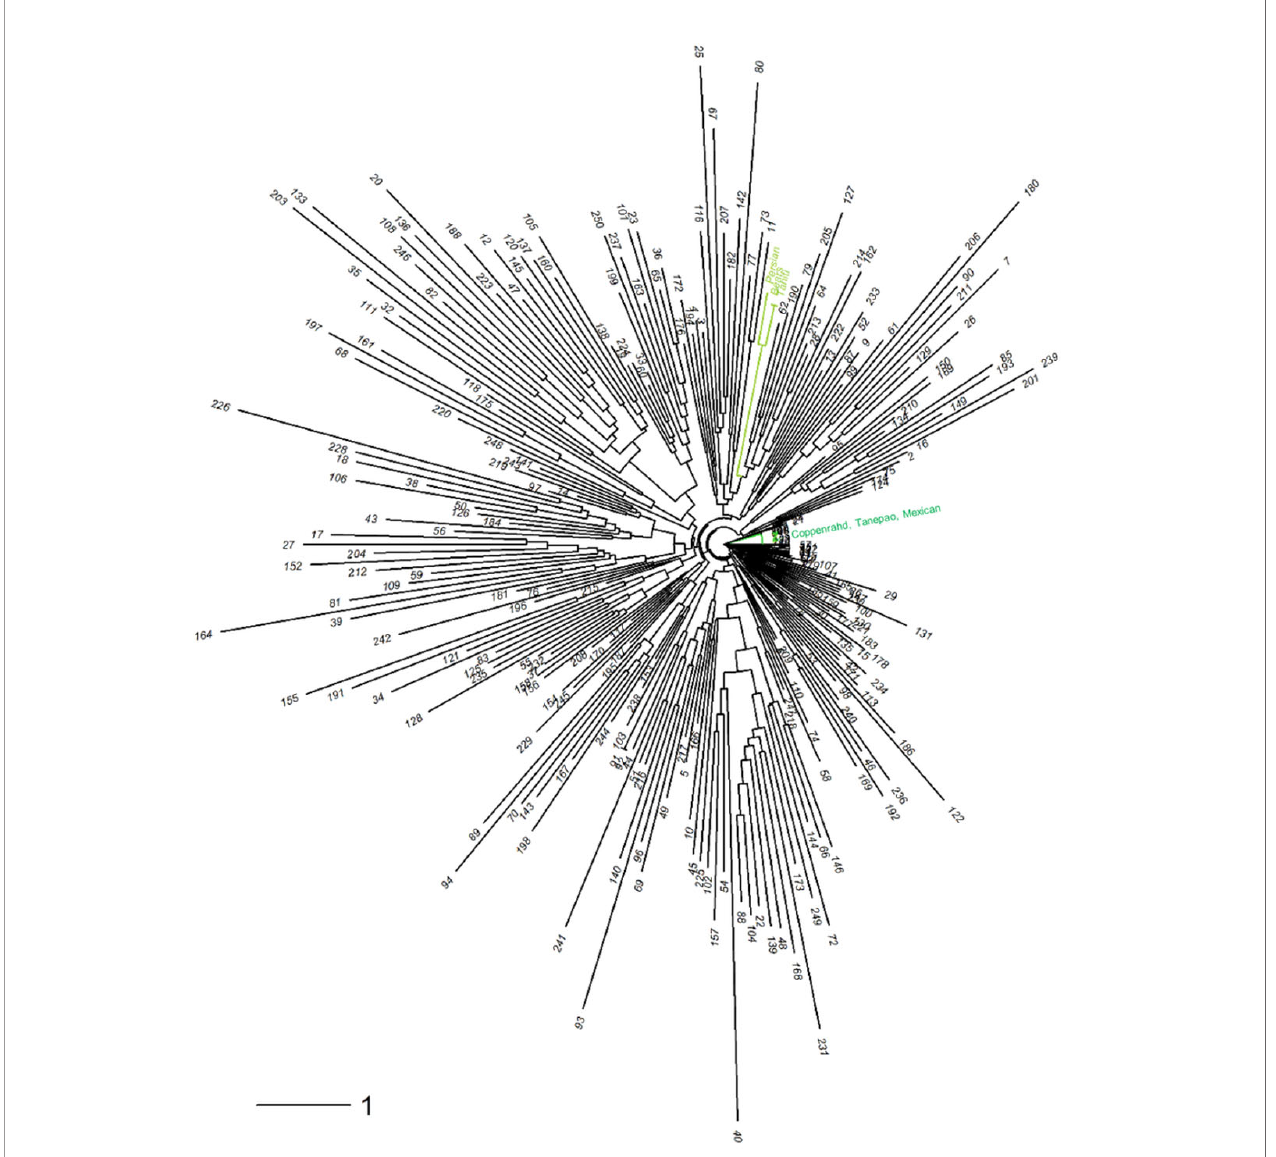
FIGURE 7 | Neighbor-joining tree performed on the 250 triploid hybrids and six varieties of lime [ ‘ Mexican ’ lime, ‘ Coppenrath ’ lime, ‘ Tanepao ’ lime (dark green); ‘ Tahiti ’ lime, Persian lime, and ‘ Bears ’ lime (light